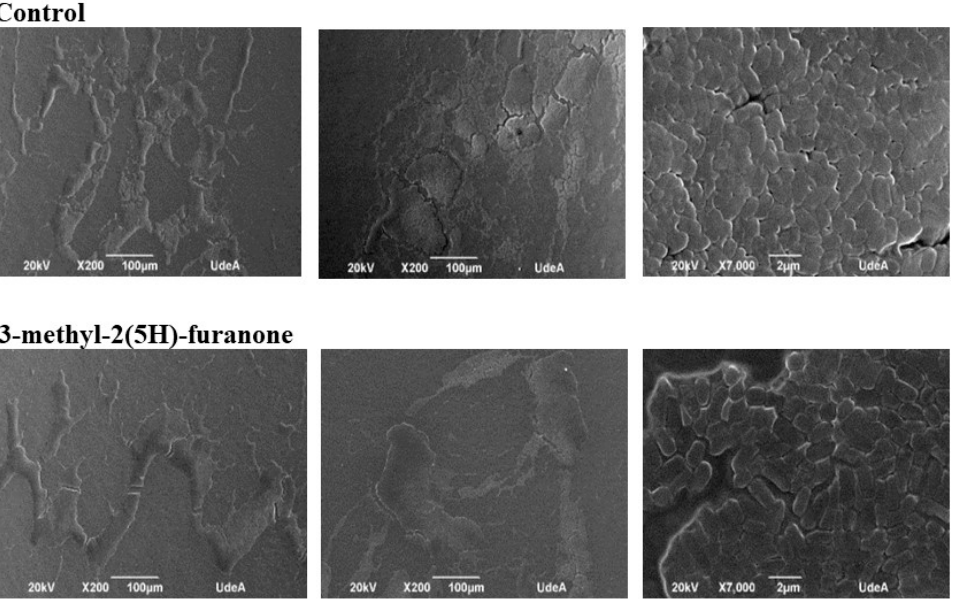
Figure 5. The appearance of the biofilm of K. pneumoniae observed with Scanning Electron Microscope (SEM) at 200X and 7000X. Upper: Culture without treatment. Bottom: Biofilm formed under the effects of 3-methyl-2(5H)-furanone. The compound reduces the colonization area and increases the interbacterial spaces.